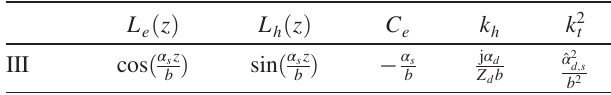
TABLE III. TM waves in region III. TABLE IV. TM waves in region